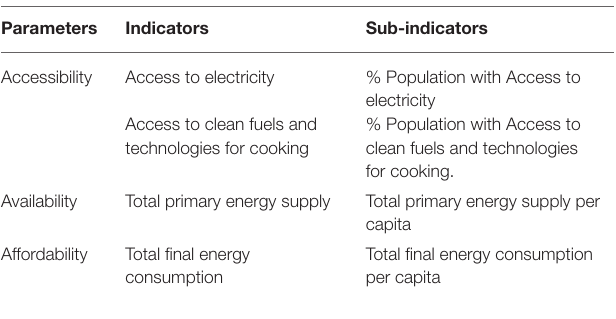
TABLE 1 | Variables of